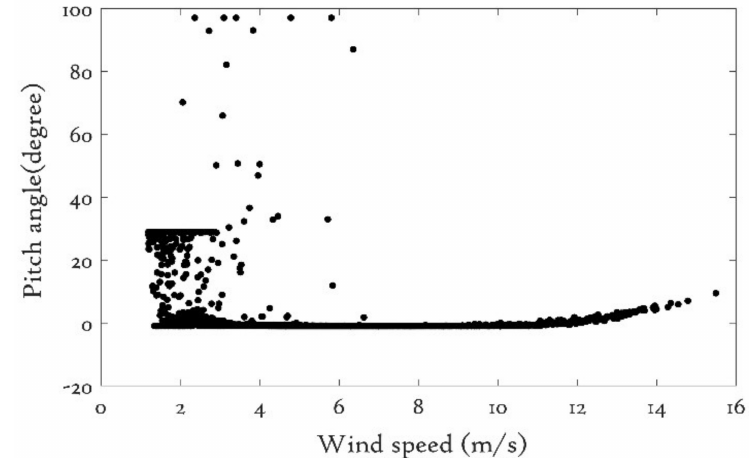
Figure 2. Measured Pitch angle curve.